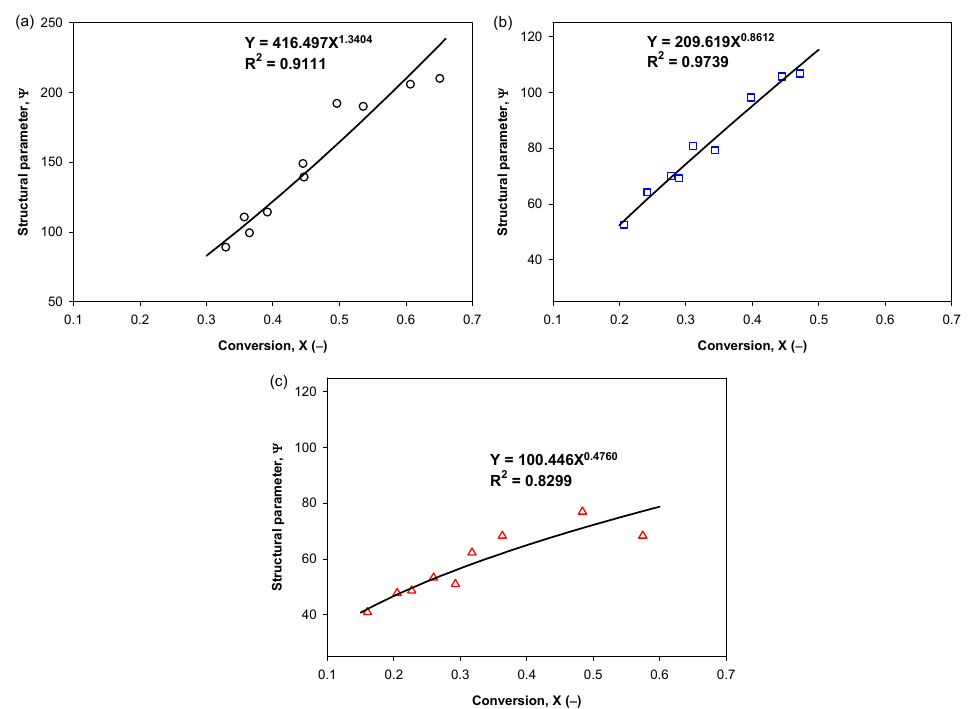
Figure 11. The relationship between the structural parameter and fractional conversion of char. Figure ( a – c ) refer to the activated carbon derived from char carbonized at 400, 500, and 600 °C for 90 min, respectively. Next, the constants C 1 and C 2 were correlated with the carbonization temperature ( T c )